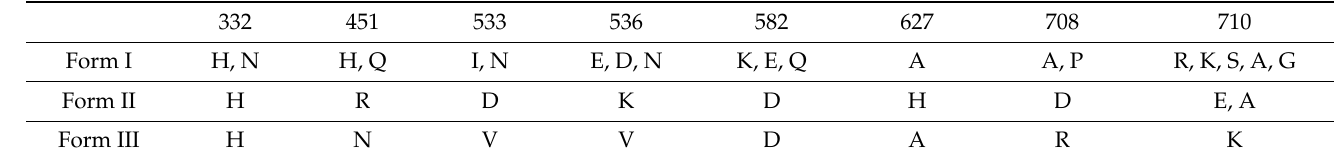
Table 3. Top eight sites of the second left-singular value in Table 1 and corresponding residues for each form. Where there are multiple residues, the first amino acid residue is the most common in that form.